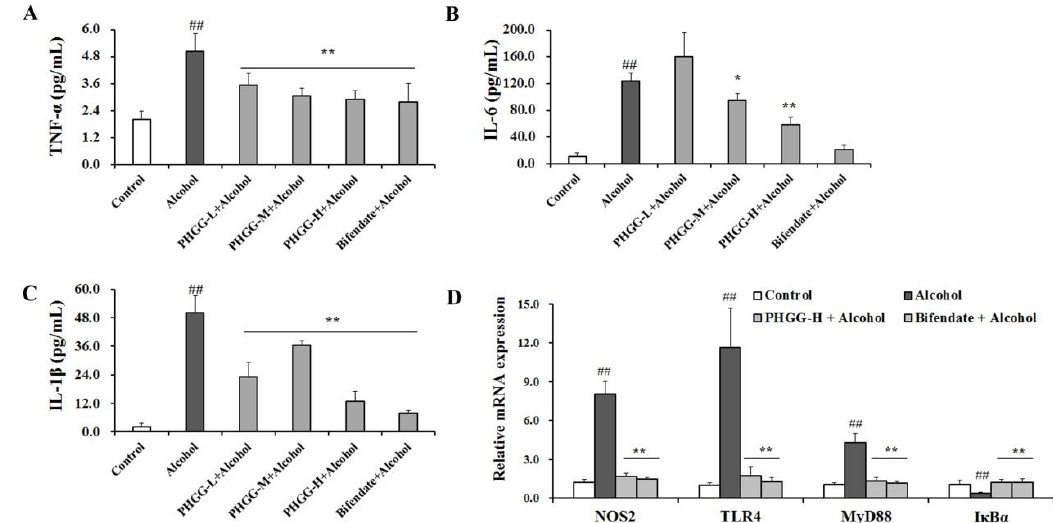
Figure 4. E ff ect of partially hydrolyzed guar gum (PHGG) on alcohol-induced inflammatory responses. Serum levels of tumor necrosis factor (TNF)- α ( A ), interleukin (IL)-6 ( B ), and IL-1 β ( C ) in alcohol intoxicated mice with or without PHGG protection were determined and used as indicators of inflammatory responses. Results are shown as mean ± SD ( n = 10). ( D ) Gene expressions of NOS2, toll like receptor (TLR)-4, MyD88, and I κ B α in liver tissues from mice of the Control group, Alcohol group, PHGG-H + Alcohol group, and Bifendate + Alcohol group were quantified by RT-qPCR analysis. Data are expressed as mean ± SD ( n = 5) of three independent experiments. “##” ( p < 0.01), significantly di ff erent when compared to the control group. “*” ( p < 0.05) and “**” ( p < 0.01), significantly di ff erent when compared to the alcohol group. PHGG-L + Alcohol: PHGG low dose + alcohol group, treated with 500 mg / kg · day of PHGG plus alcohol; PHGG-M + Alcohol: PHGG medium dose + alcohol group, treated with 1000 mg / kg · day of PHGG plus alcohol; PHGG-H + Alcohol: PHGG high dose + alcohol group, treated with 2000 mg / kg · day of PHGG plus alcohol.